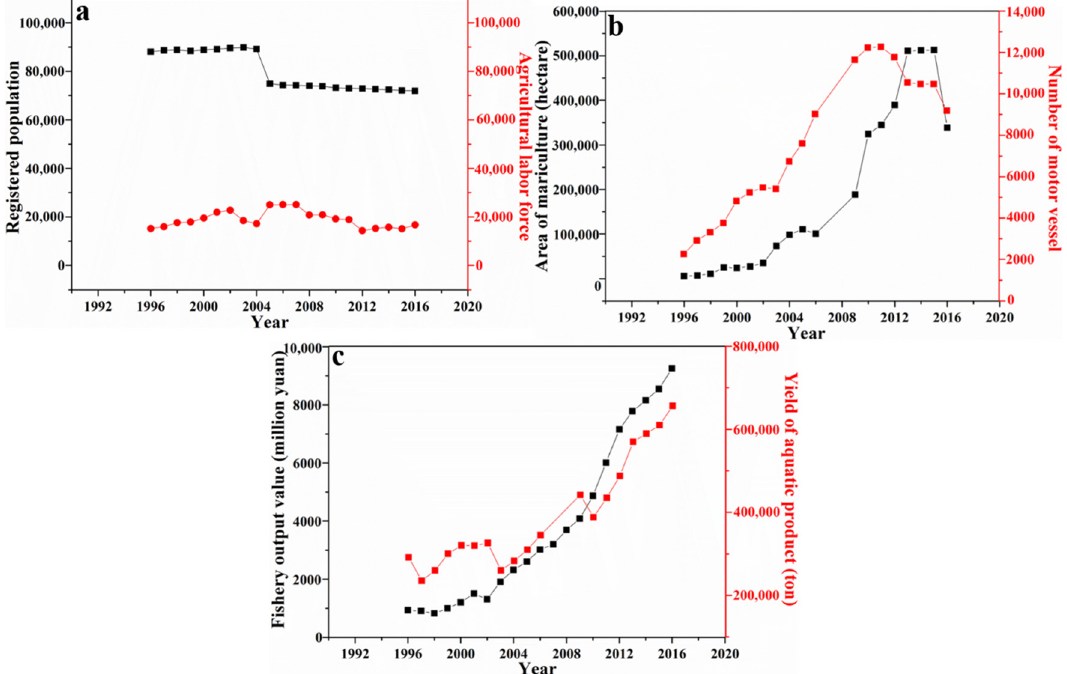
Figure 2. Year-to-year changes in ( a ) registered population and agricultural labor force; ( b ) area of mariculture and number of motor vessels; ( c ) fishery output value and yield of aquatic product.